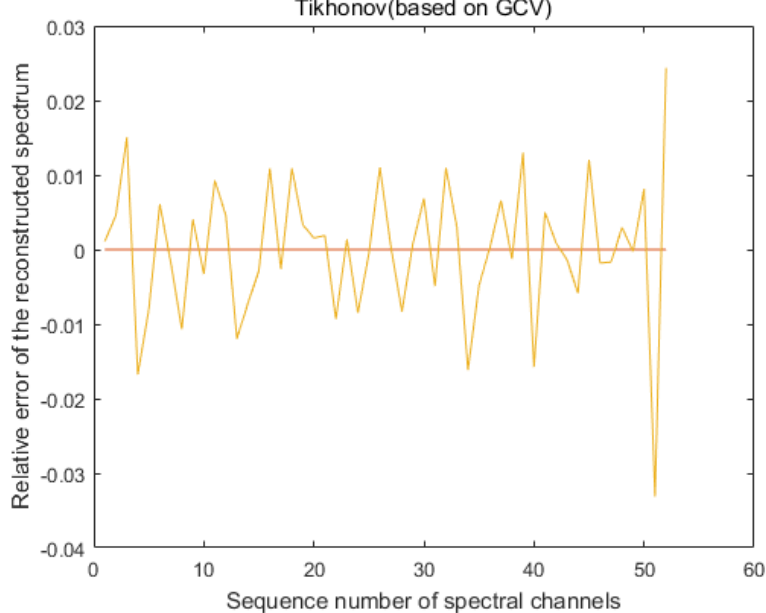
Figure 8. Recovery of the mean error of spectra using the GCV-based Tikhonov algorithm for 1000 independent experiments using the Monte Carlo method.